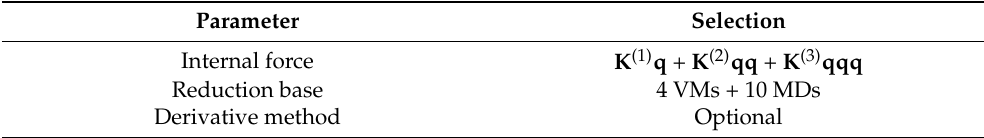
Table 1. Parameters for NLROMs in Section 4.2.1.